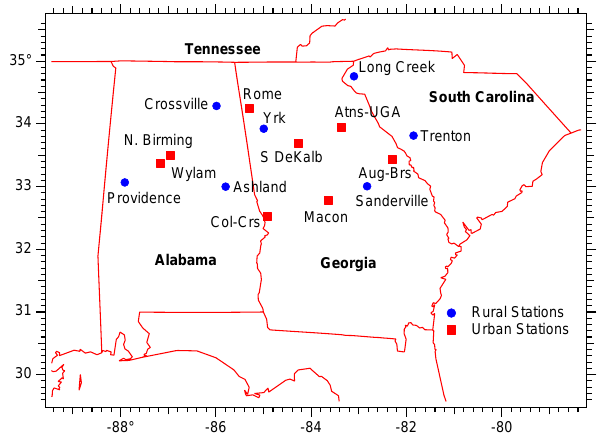
Fig. 1. Locations and designation (rural/urban) of FRM filter col- lection sites in Southeastern United States.